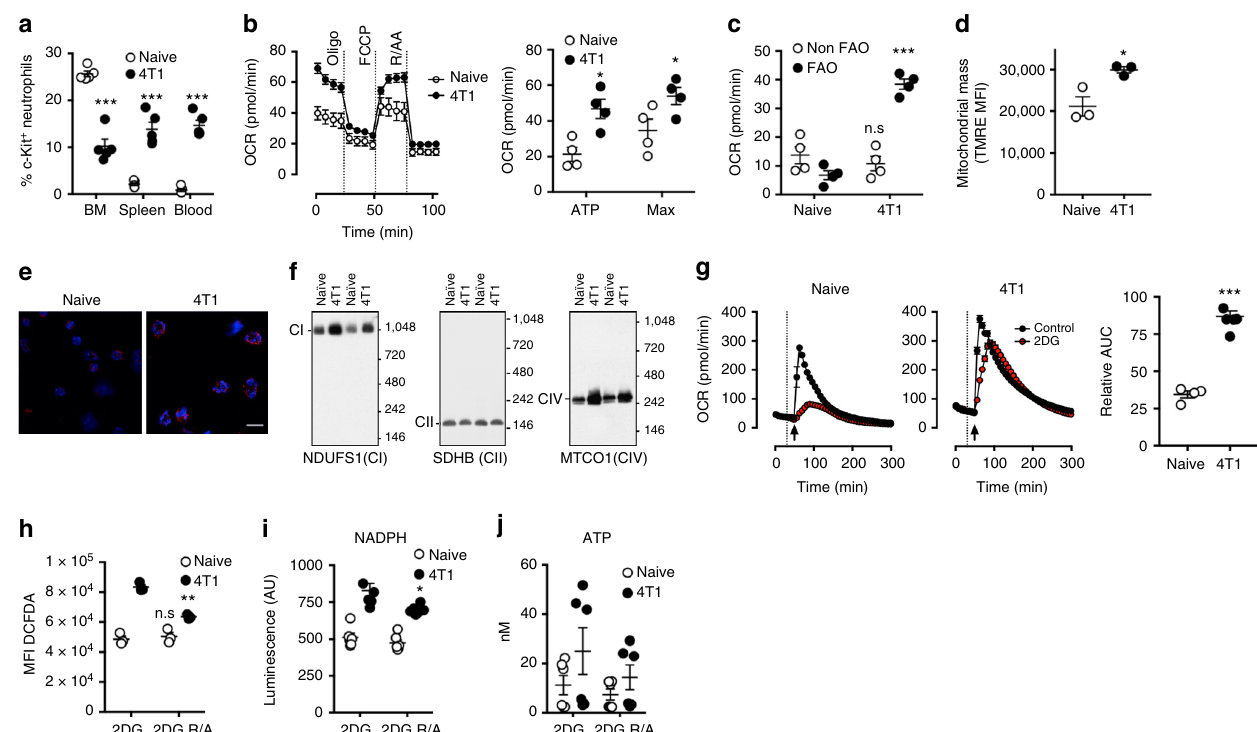
Fig. 4 4T1 tumours elicit mitochondrial metabolism in neutrophils. a The percentage of neutrophils that are c-Kit + in naive and 4T1-bearing Balb-c mouse tissues ( n = 5 per group). b Representative mitochondrial stress tests (left) of splenic neutrophils from naive and 4T1-bearing mice (oligomycin (Oligo), Carbonylcyanide- 4 (tri fl uoromethoxy)phenylhydrazone (FCCP), rotenone (R) and antimycin A (AA). ATP synthase-dependent and maximal oxygen consumption rate (OCR) quanti fi ed from multiple experiments (right, n = 4 per group). c ATP synthase OCR that is dependent on fatty acid oxidation (FAO) was assessed using etomoxir. Data ( n = 4 per group) from two independent experiments. d Median fl uorescent intensity (MFI) of tetramethylrhodamine ethyl ester (TMRE) staining in splenic neutrophils from naive and tumour-bearing mice ( n = 3). e Representative images of splenic neutrophils from tumour- bearing and naive mice stained with mitotracker CMXROS (100 μ M) and Hoechst 33342 (3.25 μ M), scale bar represents 20 μ m. f Native immunoblots for mitochondrial complex I (CI, NDUFS1) Complex II (CII, SDHB) and Complex IV (CIV, MTCO1) of splenic neutrophils from naive and 4T1-bearing mice. g Representative OCR of splenic neutrophils from tumour-bearing or naive mice following stimulation with phorbol 12-myristate 13-acetate (PMA) (arrow) in the presence or absence of 2-deoxy glucose (2DG) (dotted line). Quanti fi cation of area under the curve (AUC) of 2DG-stimulated neutrophils relative to PMA alone from multiple experiments (naive n = 4, 4T1 n = 6). h MFI of 2 ′ ,7 ′ -dichloro fl uorescin diacetate (DCFDA) (5 μ M) in splenic neutrophils from tumour-bearing or naive mice in response to PMA (20 min) following stimulation with the indicated compounds ( n = 3). i , j NADPH and ATP levels in splenic neutrophils from tumour-bearing or naive mice following stimulation with PMA in the presence the indicated compounds. Data ( n = 6) are from